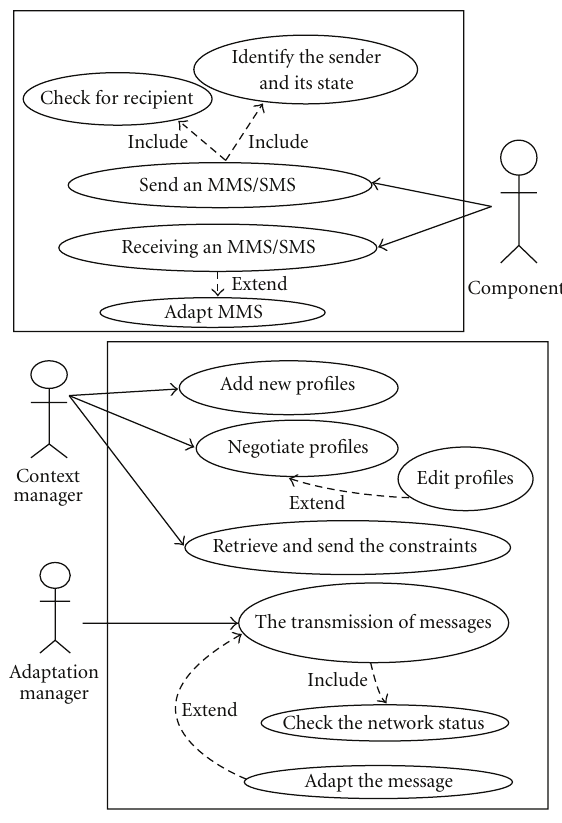
Figure 22: Use case